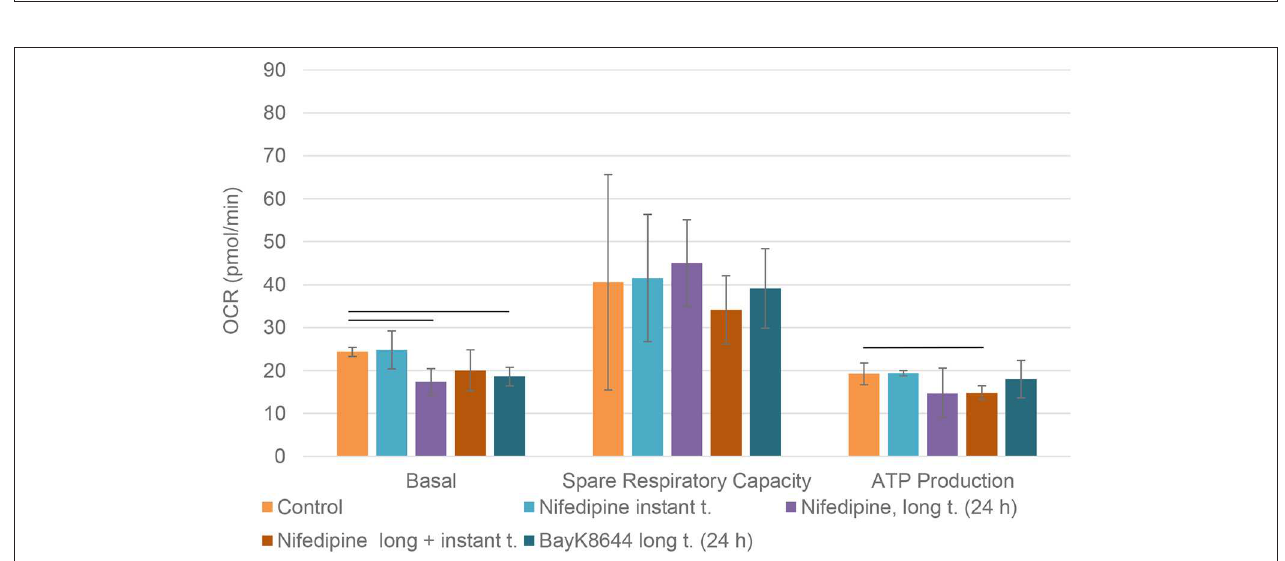
FIGURE 4 | Glycolysis in chondrocytes. The cells were treated with nifedipine (10 µ M) and BayK8644 (10 µ M) for 24h period (long t.), and additionally treated with nifedipine (10 µ M) during the measurement (instant t.). ECAR, extracellular acidification rate. Horizontal bars represent p < 0.05.